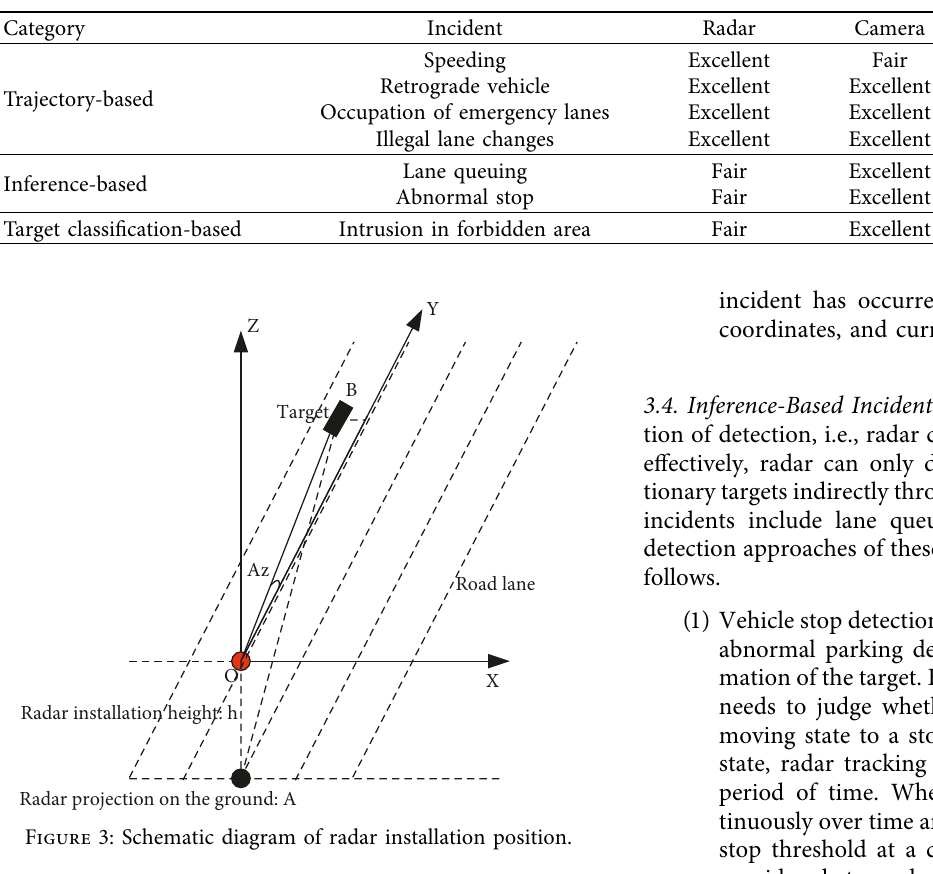
Table 2: Introduction to traffic incidents, application scenarios, and sensor detection capabilities.